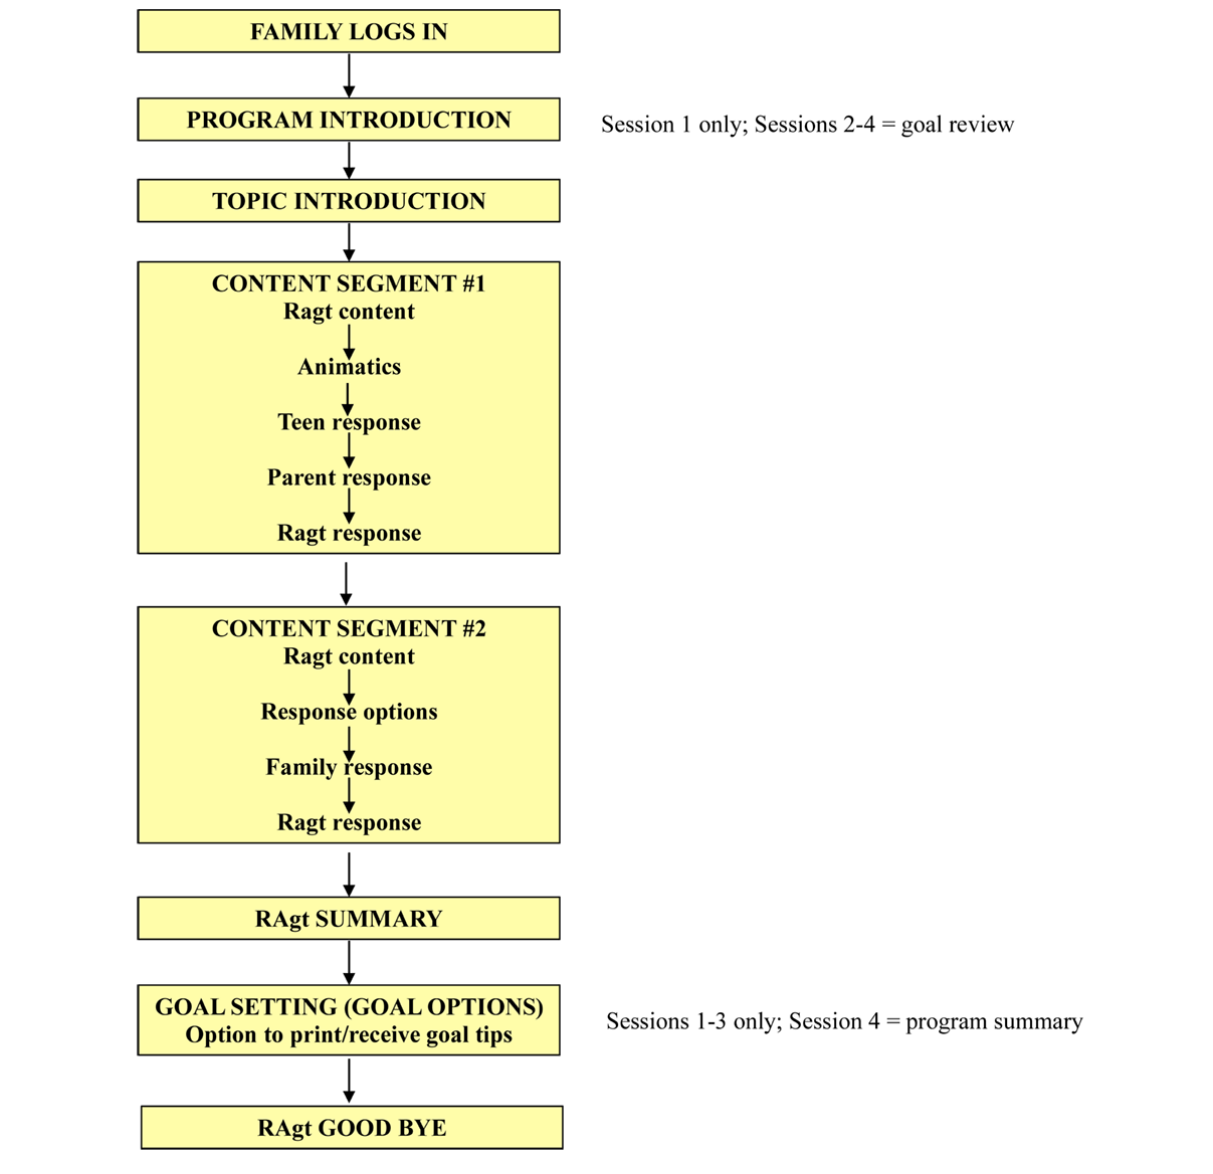
Figure 1. Family Teamwork Online module flow.